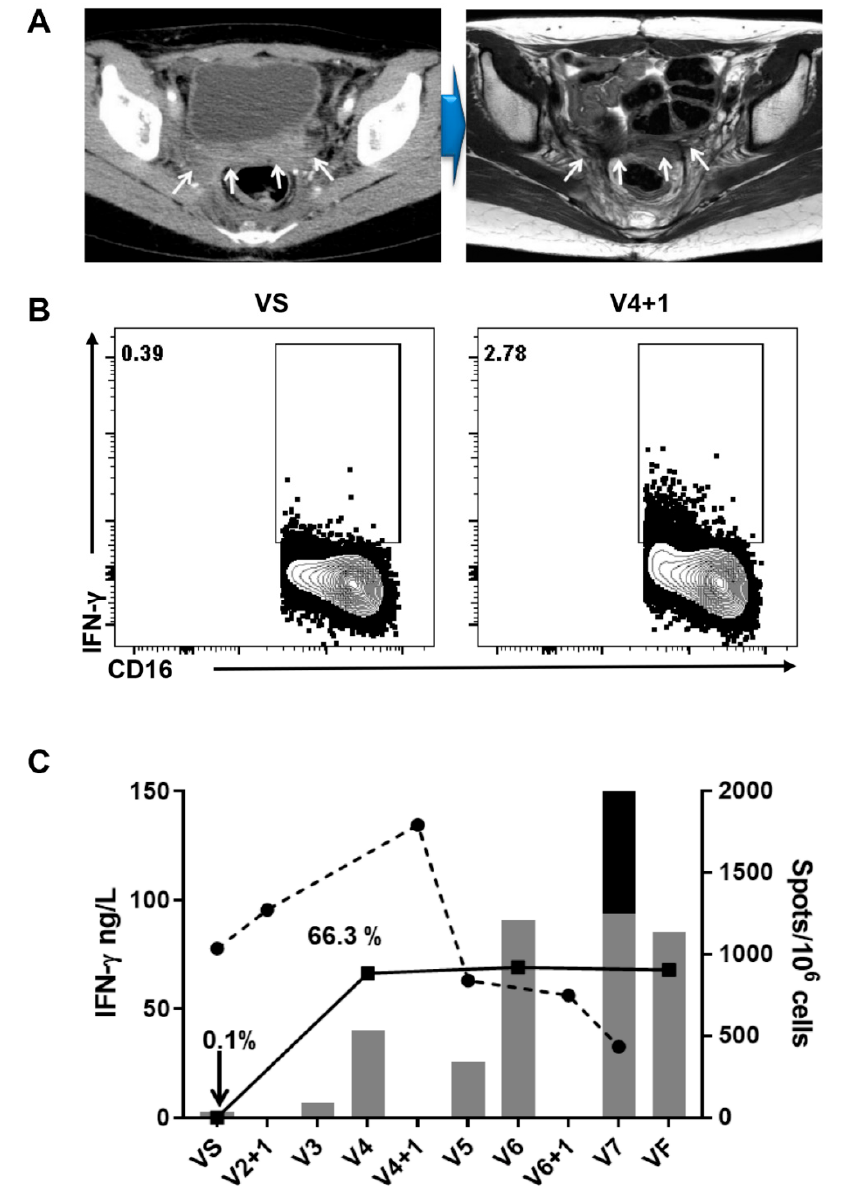
Figure 3. Radiological assessment and immune response analysis of the S02 patient. ( A ) CT scan of the target lesion before BVAC-C administration and MRI scan of the same lesion at VF. ( B ) The activation of natural killer cells in peripheral blood one day after the second administration of BVAC-C. ( C ) Immune response induced by BVAC-C administrations. Serum IFN- γ concentration, black circle with a dashed line, CD3 positive lymphocytes percent, black square with a line, and HPV-specific T cell spots, grey bars for HPV type 16, and black bars for HPV type 18.